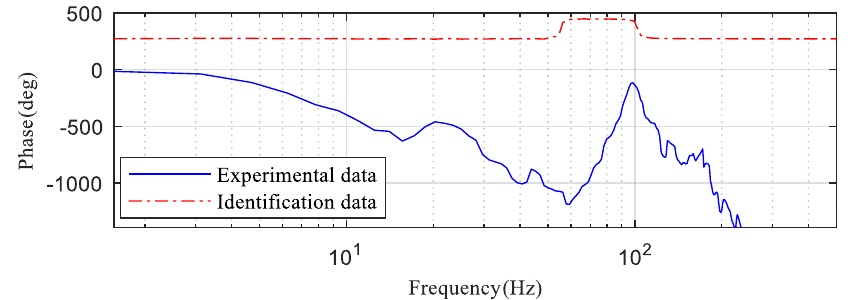
Figure 11. Phase of the FRF of experimental and identified data.